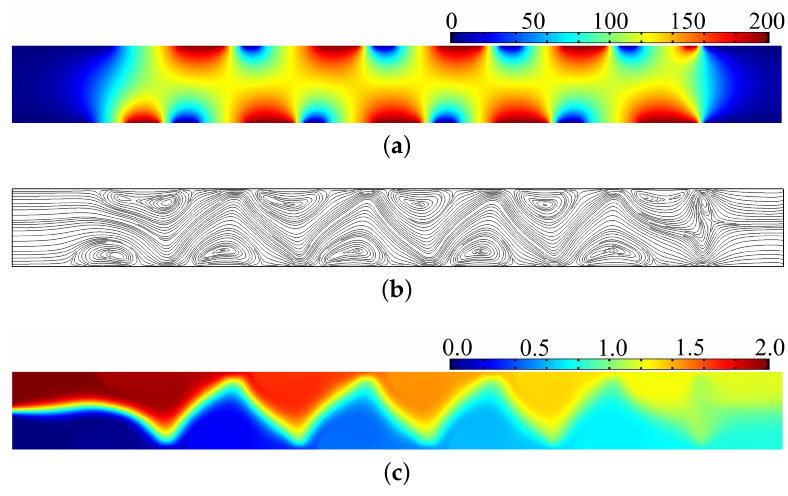
Figure 7. ( a ) Electric potential distribution corresponding to the electrode distribution shown in Figure 5b; ( b ) streamline distribution induced by the electrode distribution shown in Figure 5b; ( c ) concentration distribution in the electroosmotic micromixer with electrode distribution as shown in Figure 5b, and the value of the mixing measurement is 0.025 lower than the mixing threshold